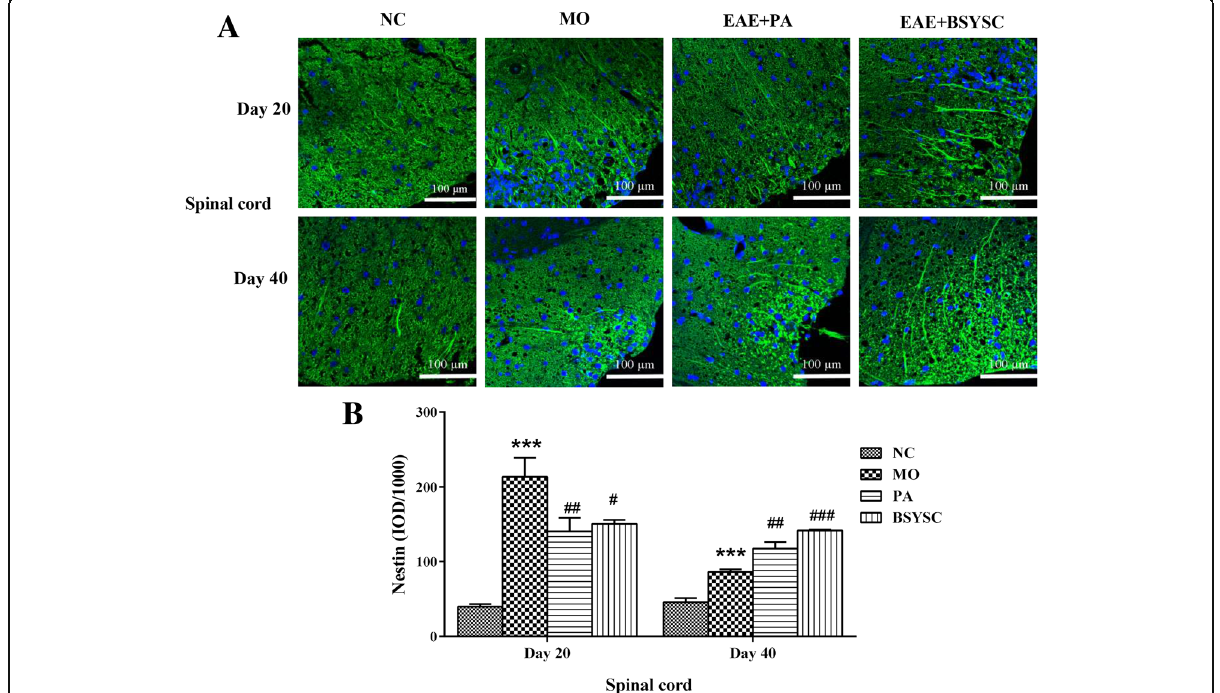
Fig. 5 Nestin expression in the spinal cord of mice treated with or without BSYSC 20 and 40 dpi. A significant decreased Nestin expression was found in the spinal cord of 20 dpi in BSYSC mice, but increased Nestin was found 40 dpi. a The representative immunofluorescent staining of Nestin was shown in each group, magnification (×40). b Semi-quantification of integrated optical density (IOD) on Nestin expression was exhibited. Data are expressed as means ± SE, n = 5 for each group. *** p < 0.01 vs. NC; # p < 0.05, ## p < 0.01, ### p < 0.001 vs.